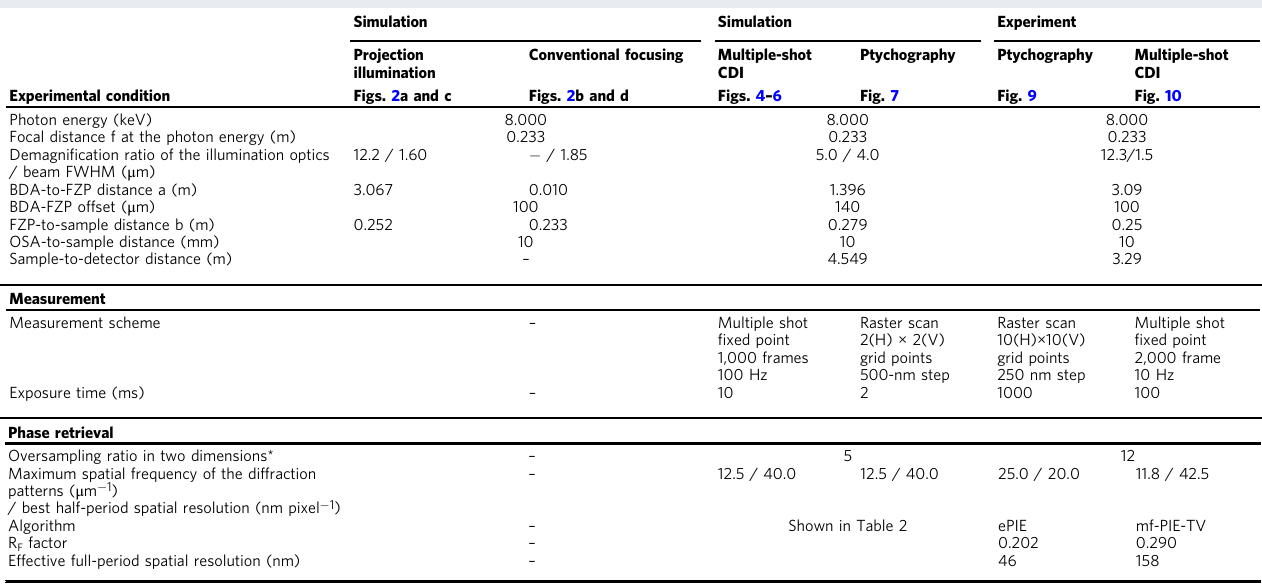
Table 1 Experimental conditions and statistics of phase retrieval